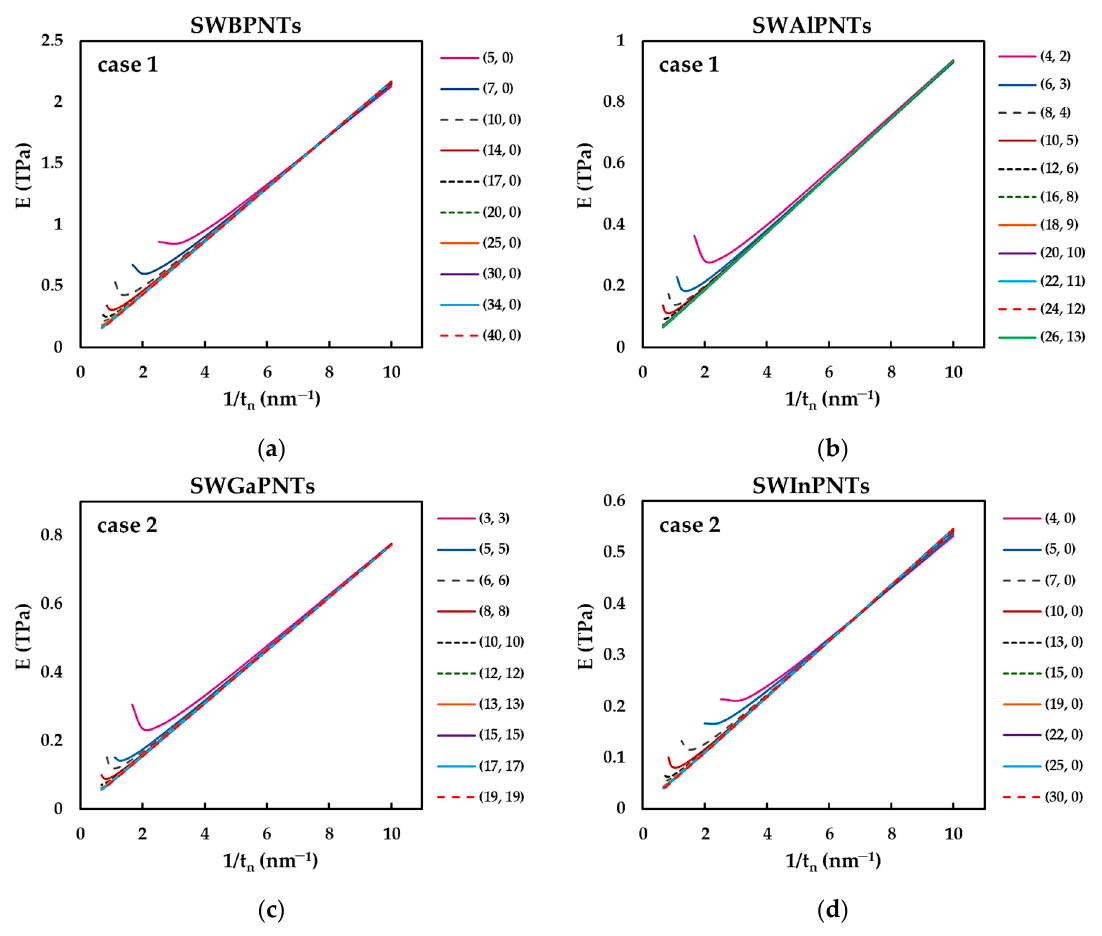
Figure 11. Evolution of the Young’s modulus, E, as a function of the inverse of the nanotube wall thickness, t n , for: ( a ) (n, 0) SWBPNTs; ( b ) (n, m) SWAlPNTs; ( c ) (n, n) SWGaPNTs; and ( d ) (n, 0) SWInPNTs; ( a , b ) case 1, ( c , d ) case 2.